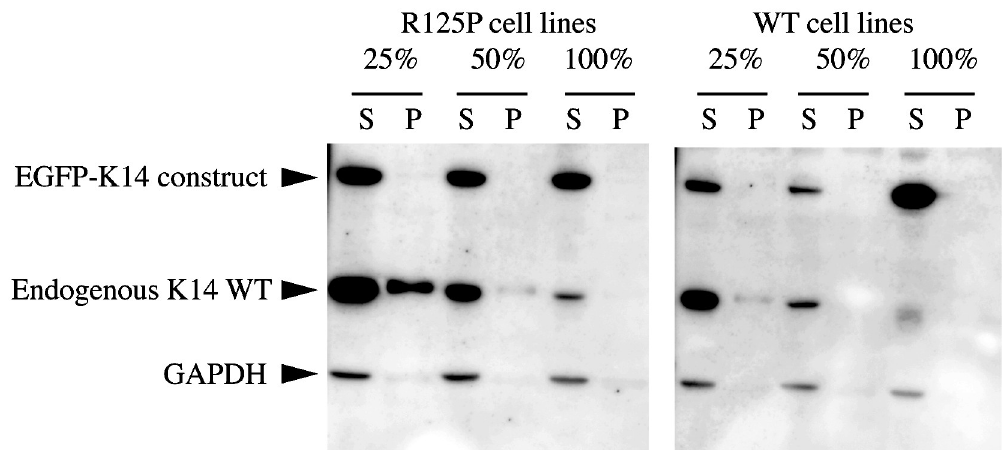
Fig 7. Western blot of K14 content in EGFP-K14 WT and R125P mutant cell lines in the total cell extract (RIPA supernatant) and the pellet fraction (after extraction with a high salt buffer). The upper band belongs to the protein derived from the EGFP-K14 construct, while the lower band to the endogenous K14 WT. 25%, 100% and 50% indicate the different EGFP-K14 clones, while S marks the supernatant fraction and P the pellet fraction of the total cell extract(s). Surprisingly, the 25% EGFP-K14 R125P cell line, which also displayed the lowest cortical stiffness and highest number of cells with keratin aggregates, contains a significant amount of endogenous K14 WT in the pellet fraction (over an order of magnitude more than the EGFP-K14 R125P protein in the band above). All other cell lines, including the 50% and 100% EGFP-K14 R125P ones have either no or only trace amounts of both EGFP labelled and endogenous K14 in the pellet